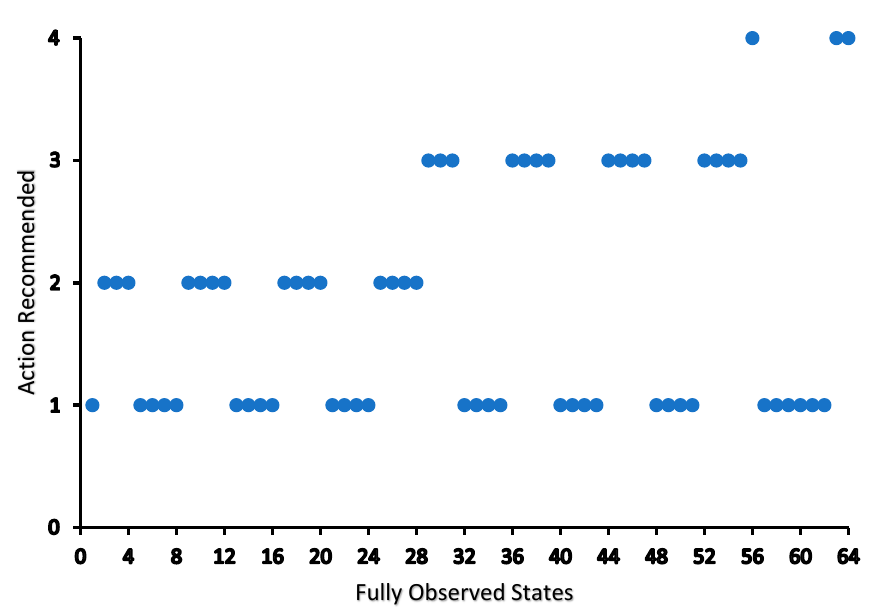
Fully Observed States Figure 3. Recommended action for the MDP model of a two-pipeline system. Figure 3. Recommended action for the MDP model of a two-pipeline system.